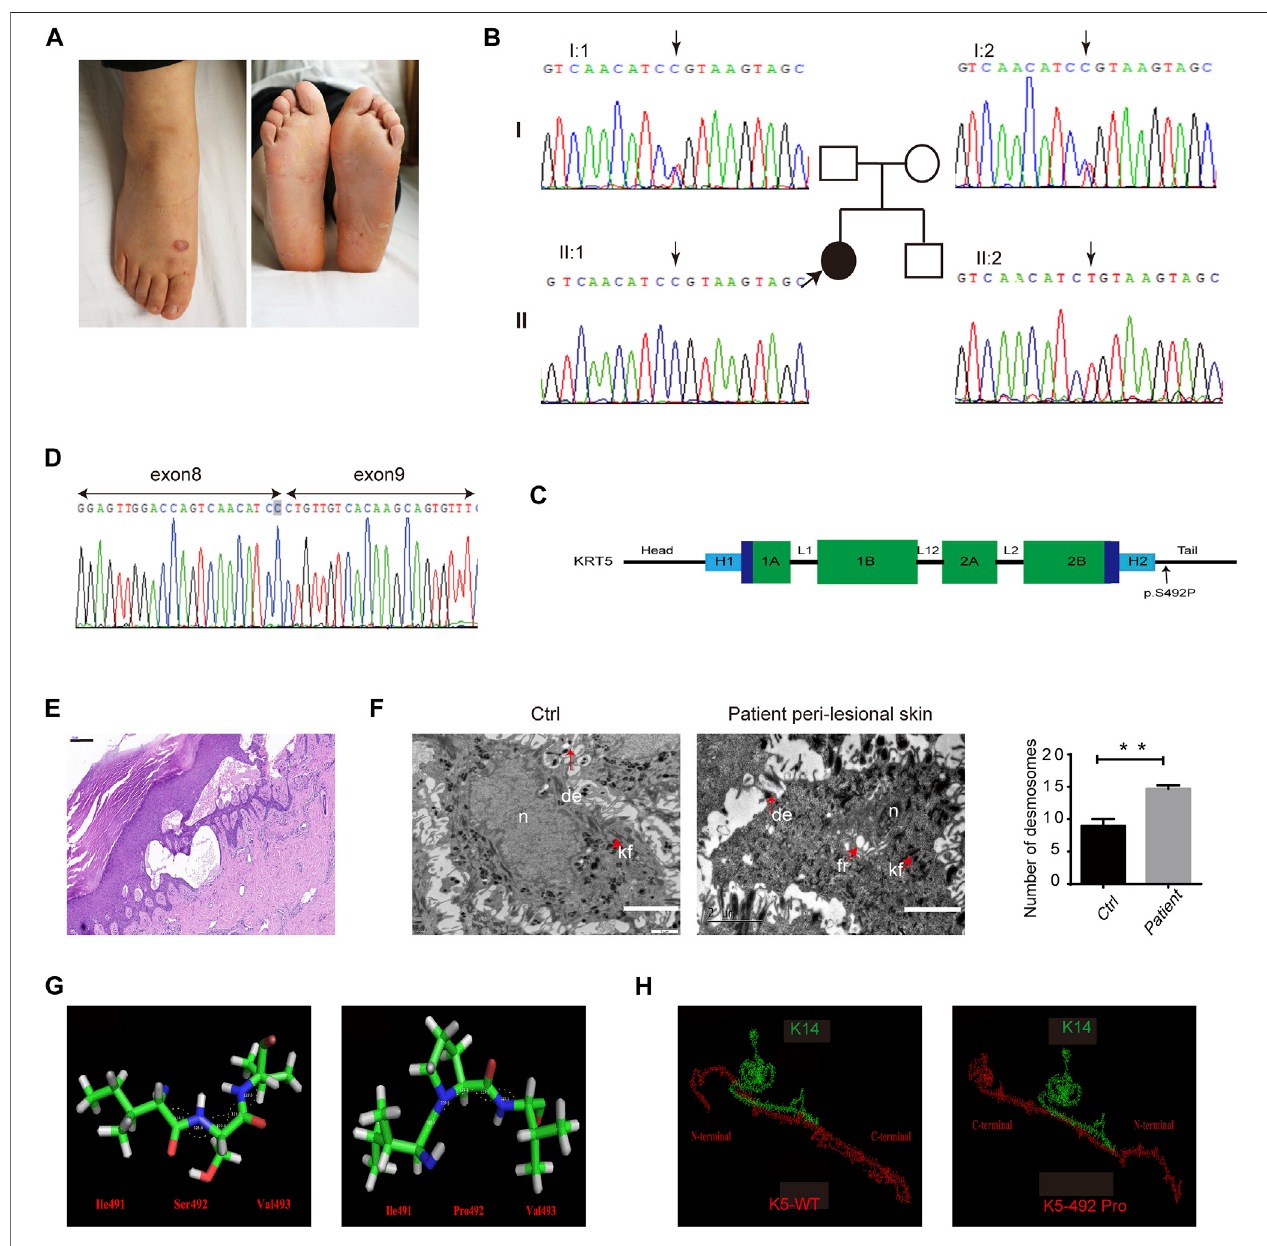
FIGURE 1 | Clinical, molecular, and histological consequences of the KRT5 mutation. (A) The patient showed localized blistering. (B) Partial KRT5 sequence from the patient(II:1)showsthehomozygousmissensevariantc.1474T > C,whichwasinheritedfrombothofherunaffectedparents. (C) SchemaoftheproteindomainsofK5andthe locationofthemutationintheproband. (D) RNAanalysisindicatedthatthemutationdidnotin fl uencemRNAtranscriptionbutchangedaserineresiduetoaprolineresidue. (E) Affected skin patches showed extensive epidermal thickness and intraepidermal blisters. Bar, 200 µm. (F) Transmission electron microscopy (TEM) showed multiple fracturesinthecytoplasm,enlargedintercellularspaces,theclumpingofkeratin fi laments,andincreasednumbersofdesmosomes (right) comparedtothenormalcontrol (left) . kf,keratin fi laments.de,desmosomes.fr,fracture.n,nucleus.Bars,2 µm.Statisticalsigni fi cancewasassessedbyunpairedtwo-tailedStudent ’ s t -test. n (cid:1) 3,** p < 0.01. (G) The structures of three residues and angles between their atoms (Ile491-Ser492-Val493) in wild-type and in mutant K5. These angles were 114.3 ° , 128.0 ° , 109.0 ° , 118.0 ° , and 123.5 ° in wild-type K5 and 123.5 ° , 119.6 ° , 111.1 ° , 117.0 ° , and 122.1 ° in mutant K5, respectively. (H) The interactions between wild-type K5 and mutant K5 with K14.